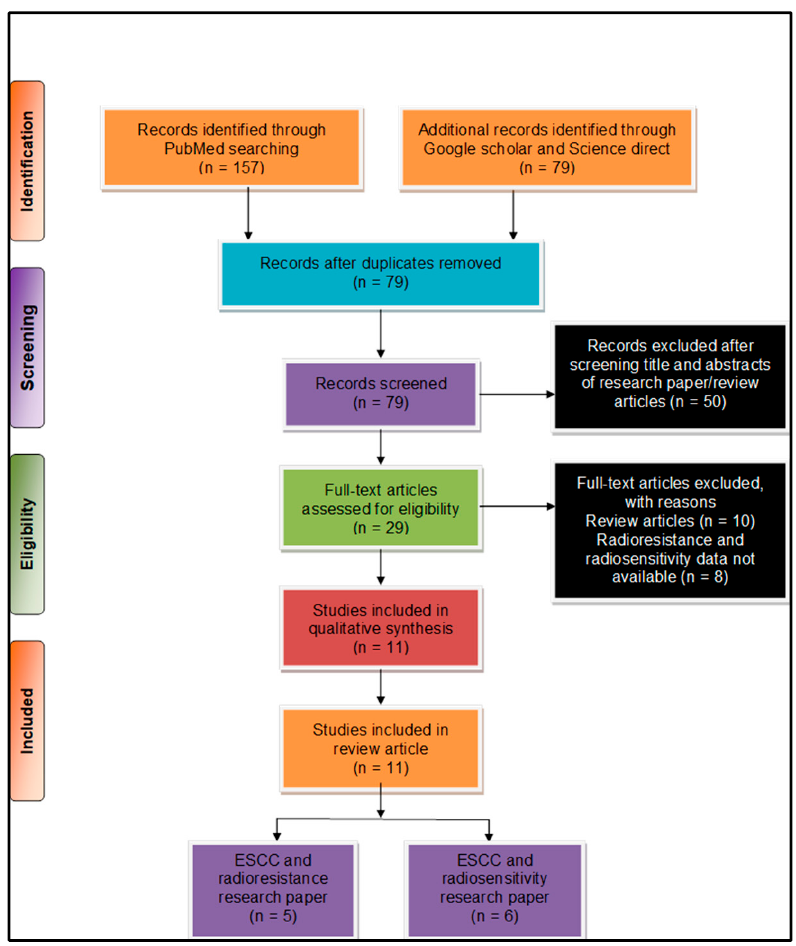
Figure 1. Preferred reporting items for systematic reviews and meta-analysis (PRISMA) flow chart describing the process of literature search and study selection related to esophageal squamous cell carcinoma (ESCC) and radioresistance / radiosensitivity. The total number of 11 relevant research articles were included in the review.